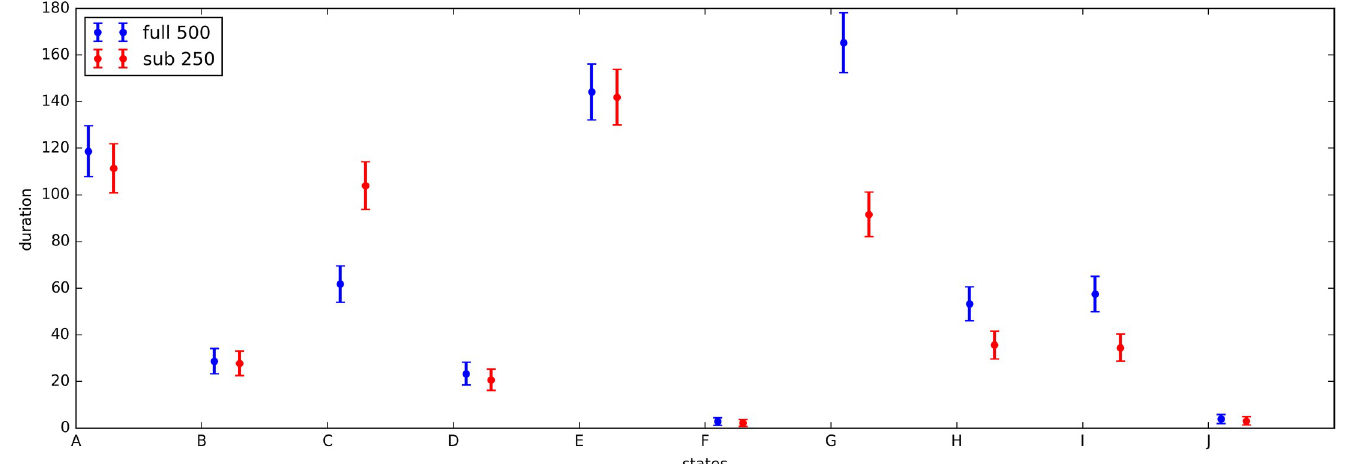
Fig 7. Lambda and variance of parameters of the duration